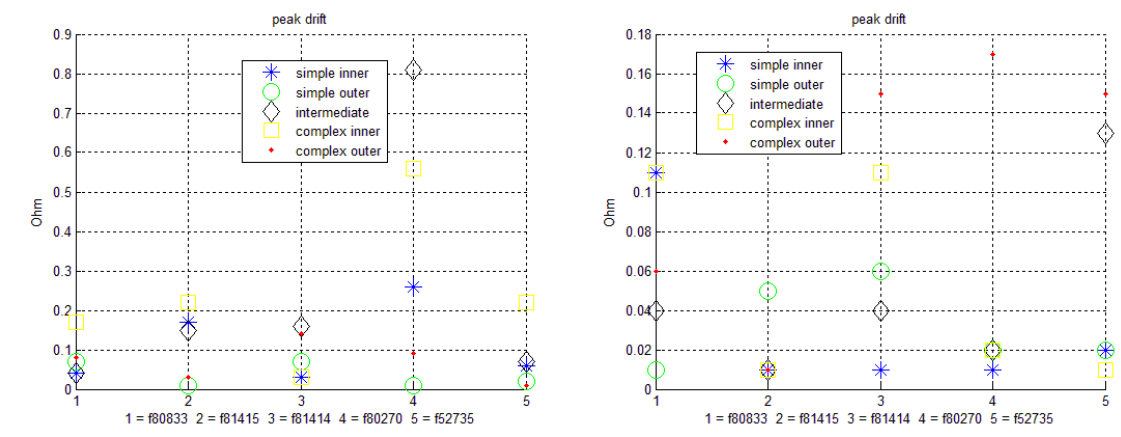
Figure 14. Peak drift: ( left ) un-insulated case; ( right ) insulated case.